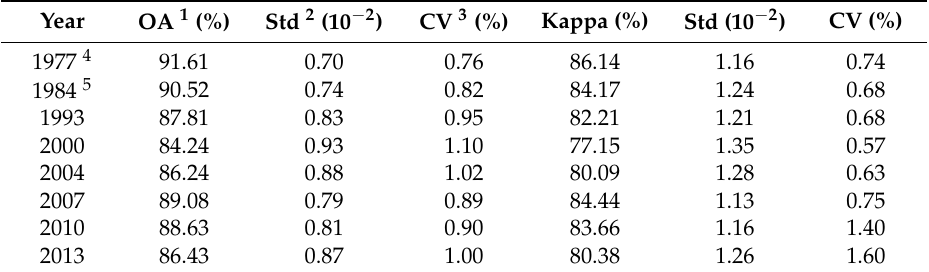
Table B1. Overall accuracy assessment of the LULCC classification results.